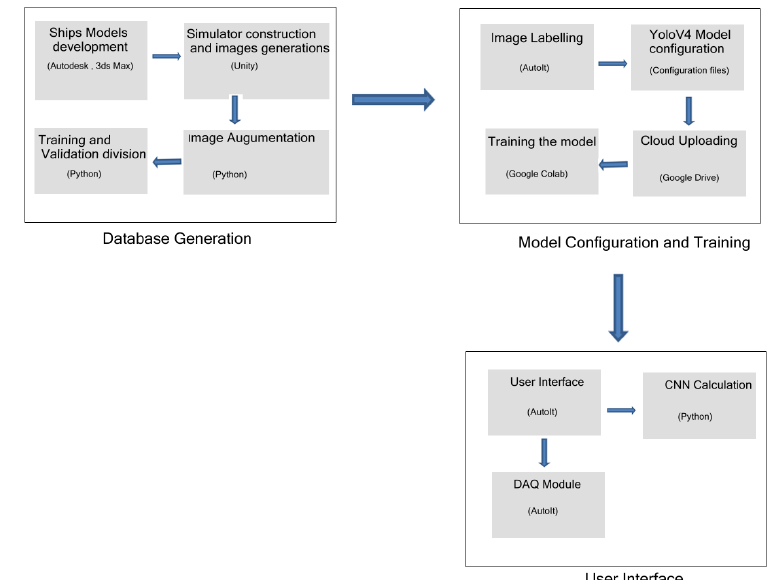
Figure 9. Steps Flow Chart.